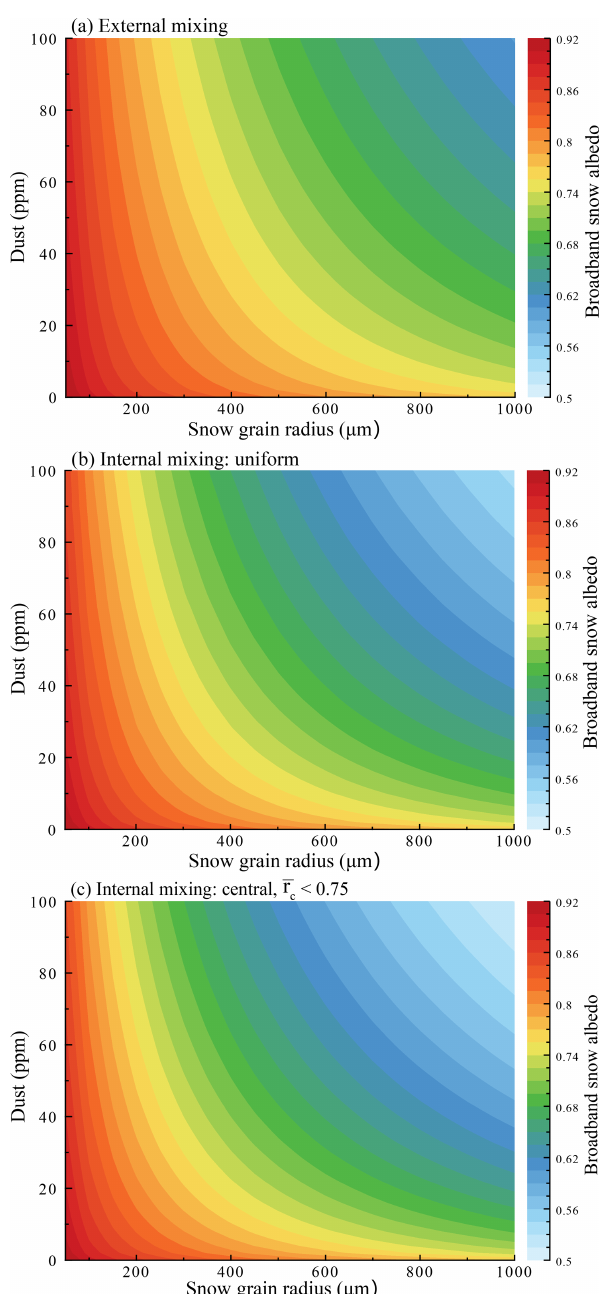
Figure 7. Broadband snow albedo ( α integrated ) variations affected by different dust mass concentrations and snow grain radii for (a) external mixing, (b) internal mixing (uniform), and (c) internal mixing (central, r c < 0 .